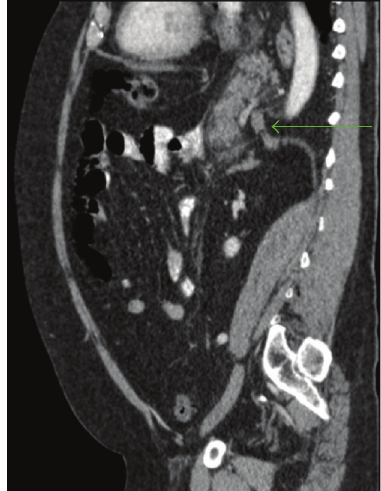
Figure 2: Sagittal plane; diaphragmatic crura impinging the pan-